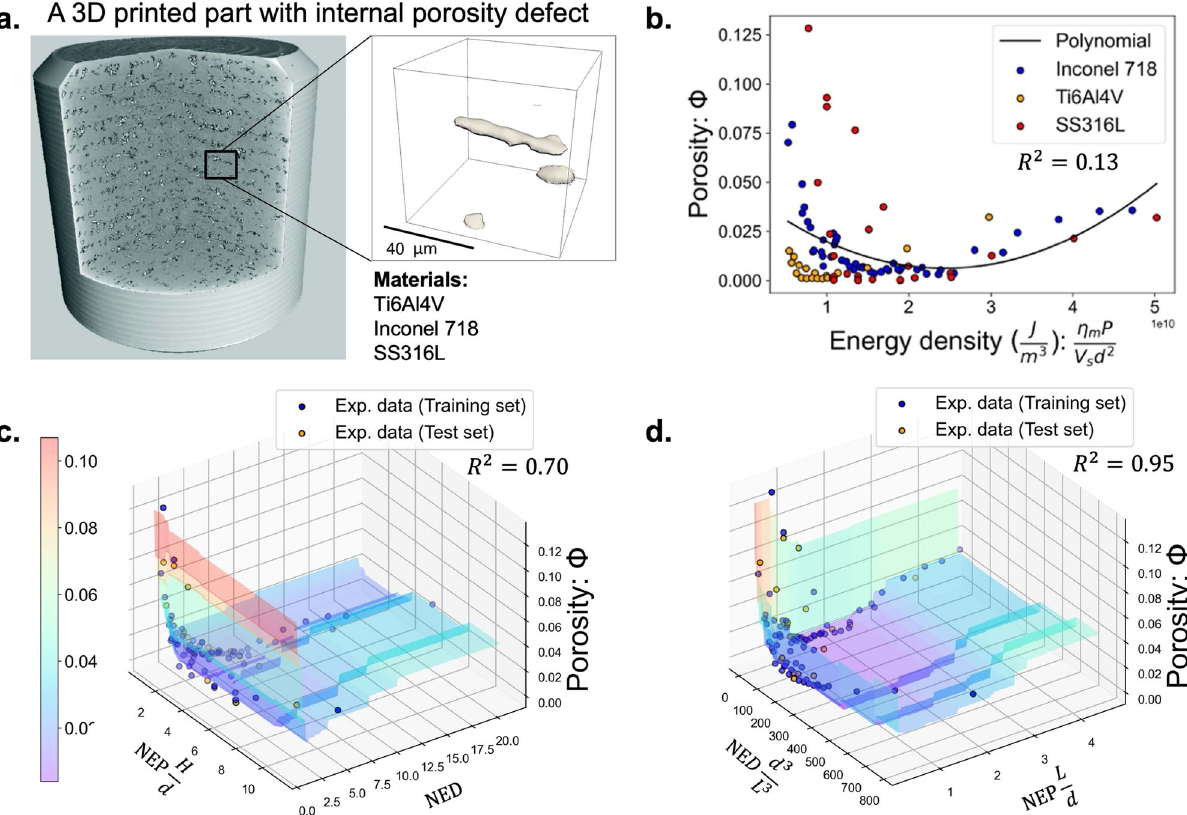
Fig. 3 | Discover dimensionless numbers governing porosity formation during 3D printing. a A schematic of a 3D printed metal part with internal porosity defects 50 . The dataset includes X-ray micro-computed tomography (micro-CT) measurements on three different materials. b Porosity measurements with varying energy density values, a traditionally combined parameter for correlating porosity